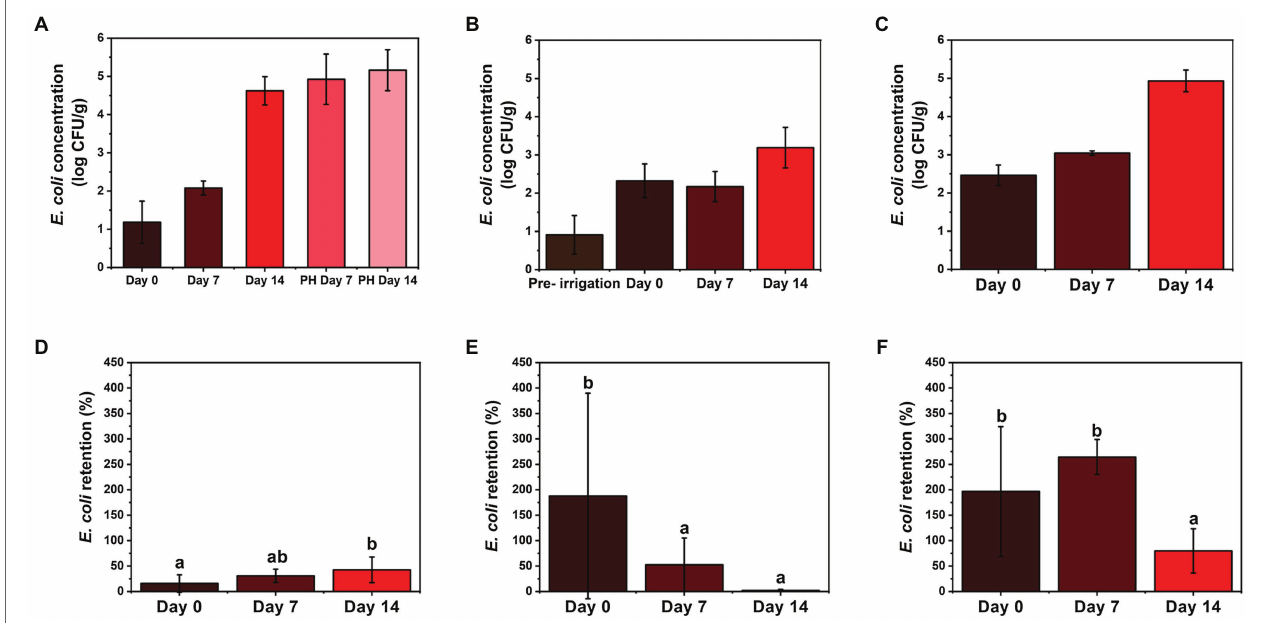
FIGURE 3 | Comparison of E. coli concentration on (A) foliage, (B) soil, and (C) leachate in log CFU g −1 or log CFU ml −1 (wet weight basis) and retention on (D) foliage, (E) soil, and (F) leachate in % over time (days 0, 7, and 14 and post-harvest (PH) days 7 and 14), respectively. Retention was calculated by dividing E. coli sample concentration (CFU ml −1 or CFU g −1 ) by weekly E. coli irrigation water concentration (CFU ml −1 ). Moisture content of foliage = 91.3% and soil = 4.44%. Sample sizes: wastewater = 10 ml, leachate = 10 ml, foliage = 5 g, and soil = 2 g. Error bars denote standard deviation for arithmetic mean ( n = 6 for day 0 foliage and n = 12 for all others). Different letters indicate statistical difference using Tukey-Kramer HSD, α =